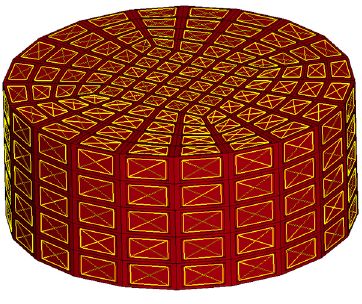
Figure 13. Numerical model of the homogeneous honeycomb material, with surfaces used as air- leakage boundaries. Table 5. Parameters of the air enclosed inside the cores, according to the assumptions of the AIR-